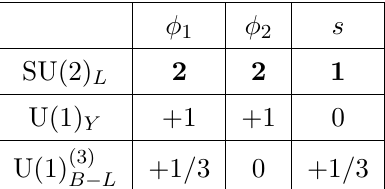
B (cid:0) L charge of the third family quarks is +1 = 3, while that B (cid:0) L charges. B (cid:0) L